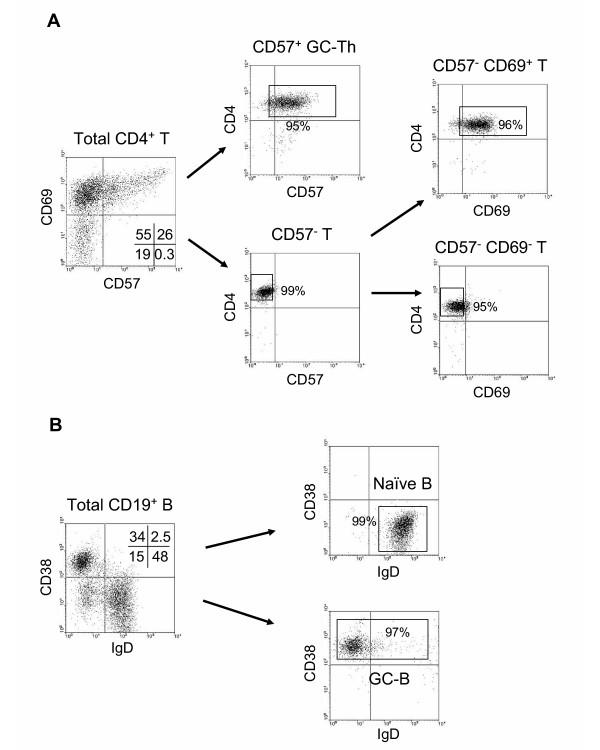
Isolation of human tonsil T cell and B cell subsets examined in this study. T cell subsets and B cell subsets were isolated from tonsils as described in the materials and methods section and were used in this study. The frequencies of the populations in total tonsil CD4+ T or CD19+ B population are 15–25% for CD4+CD57+ GC-Th cells, 50–60% for CD57-CD69+ T cells, 20–30% for CD57-CD69- T cells, 40–60% for CD19+CD38-IgD+ naïve B cells and 30–40% for CD19+CD38+IgD- GC-B cells.